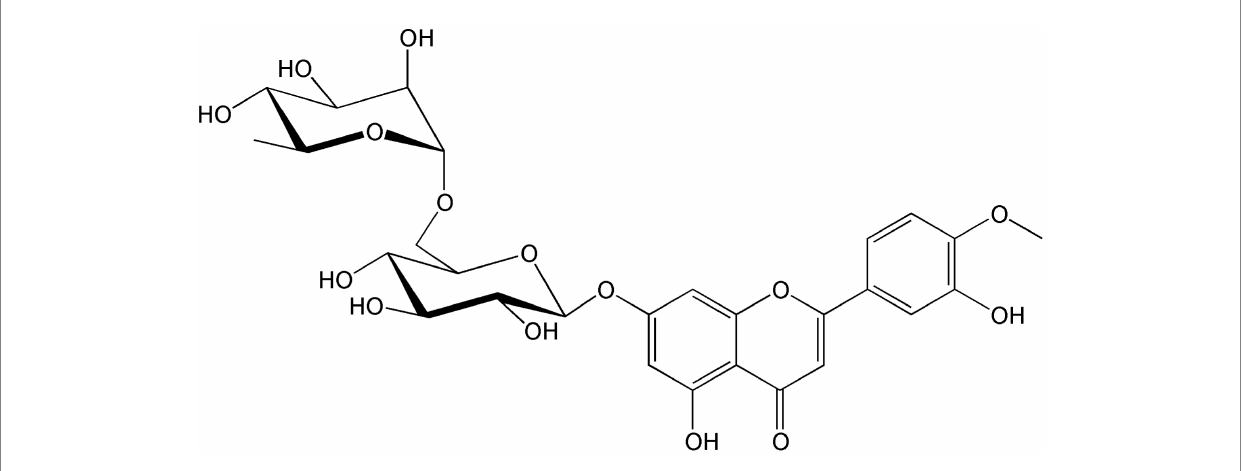
FIGURE 6 Chemical structure of diosmin.